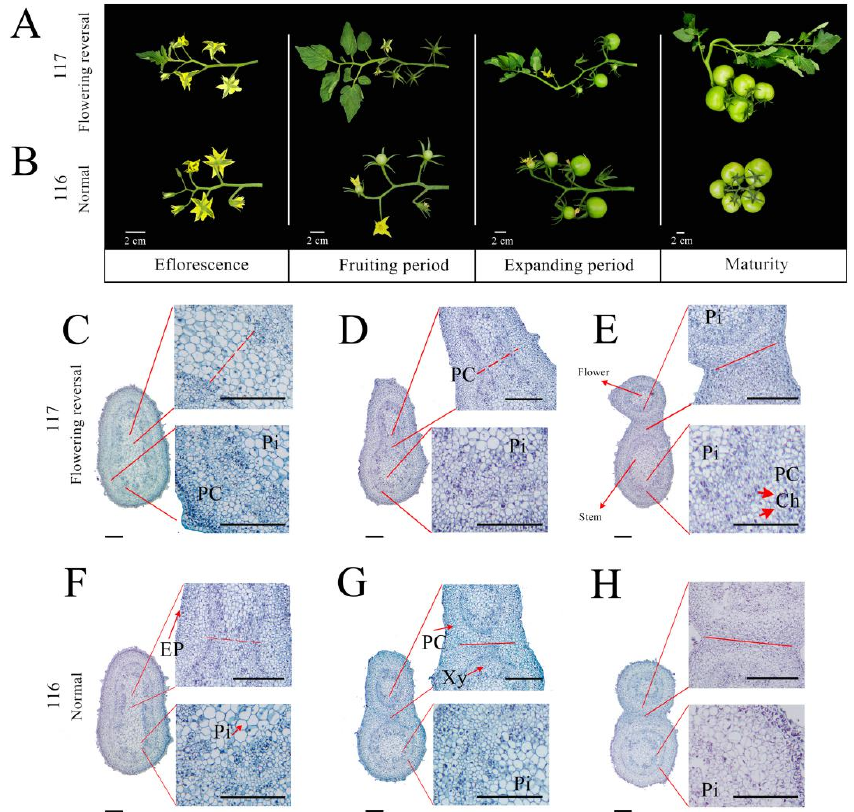
Figure 1. Phenotypic changes in the process of flowering reversion. ( A , B ) Phenotypes of flowering reversion with flower and fruit growth in ‘117 ′ ( A ) and ‘116 ′ ( B ) plants. ( C – H ) Microscopic observations of changes in flowering reversion in ‘117 ′ ( C – E ) and ‘116 ′ ( F – H ) at three different times (consistent with the Early, Mid and Late periods of the RNA-seq assay sampling time). The black solid line ( C – H ) represents a scale of 500 μ m. The red line ( C – H ) represents the distinction between the flower Pi: Pith, PC: Parenchyma cell, Ch: Chlorophyll, EP: Epidermal, Xy: Xylem.